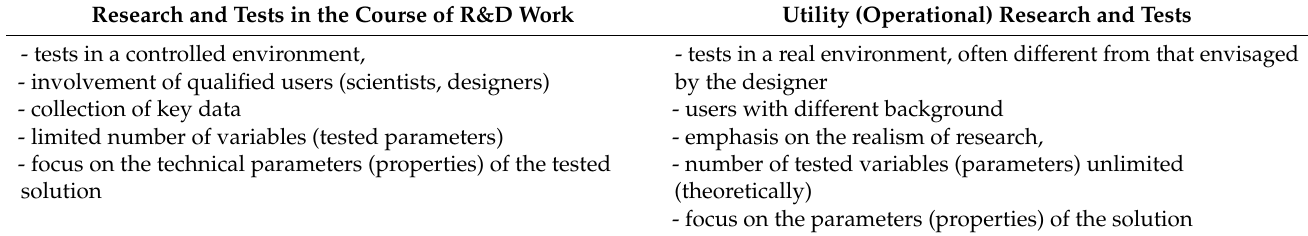
Table 2. Research and tests in the course of R&D work and utility (operational) tests (by authors based on [67]). Research and Tests in the Course of R&D Work Utility (Operational) Research and